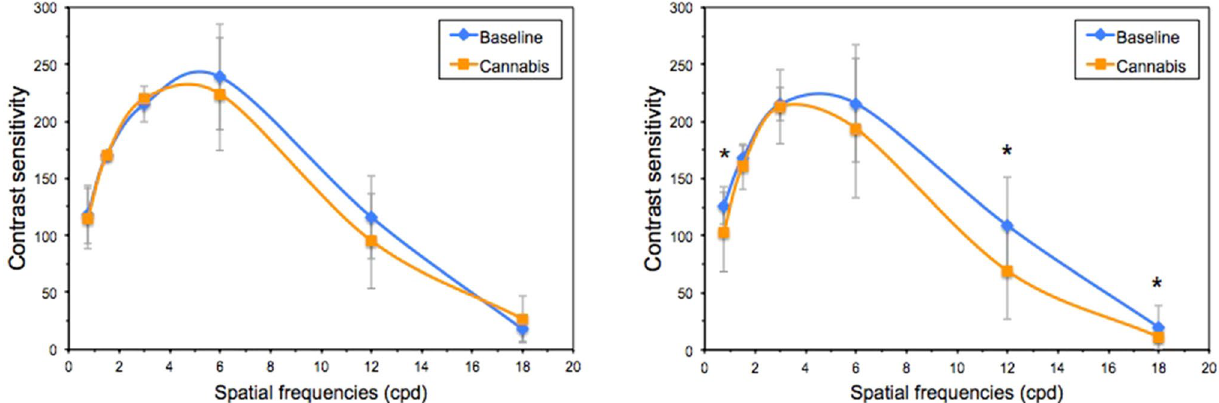
Figure 4. Mean binocular contrast sensitivity function for groups 1 (left) and 2 (right) in the baseline session and after smoking cannabis. * indicates spatial frequencies for which there are significant differences (Wilcoxon test) and error bars indicate the SD. cpd, cycles per degree.